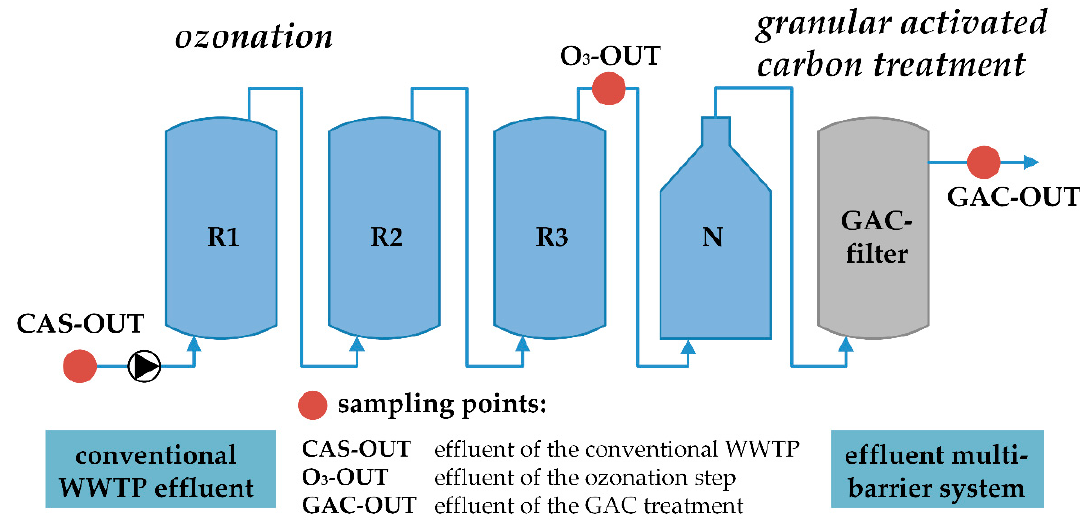
Figure 1. Flow scheme of the advanced treatment demonstrator plant with sampling points (CAS: conventional activated sludge, R: ozone reactor, N: feed tank for GAC-filter, GAC: granular activated carbon).